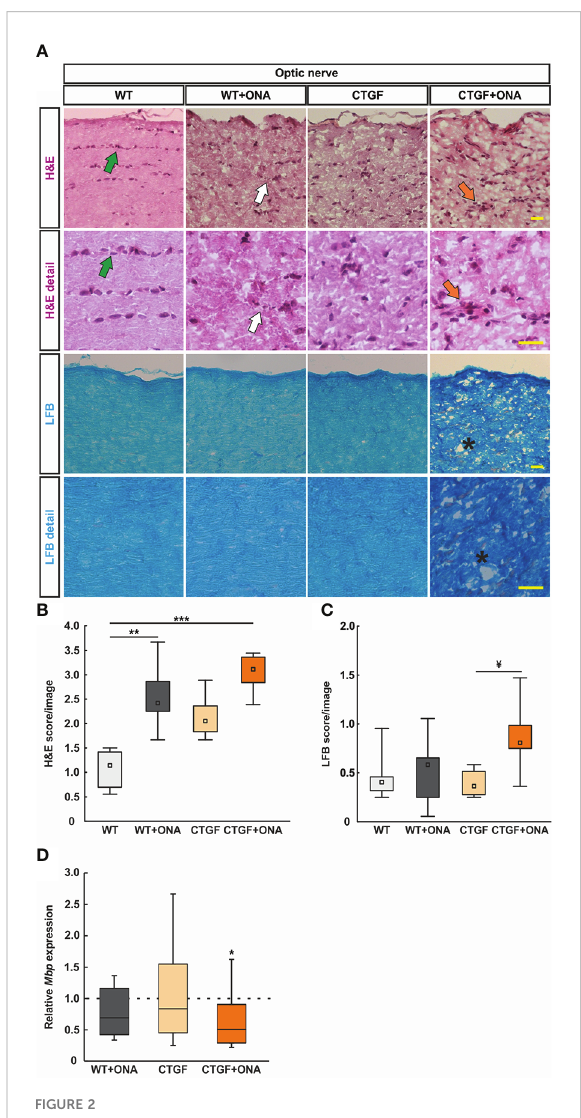
FIGURE 2 Enhanced optic nerve degeneration. (A) Longitudinal optic nerve sections were stained with H&E (cellular in fl ammation) and LFB (demyelination) and are shown as overview and in detail. In the H&E staining, healthy optic nerves show a linear formation of the nuclei (green arrows), which is disrupted in glaucomatous optic nerves (white arrows) and might comprise cellular conglomerates (orange arrows). LFB stained myelin sheats in healthy optic nerves resembles combed bundles in a parallel arrangement, which is interrupted in CTGF+ONA optic nerves (stars). (B) The H&E score revealed a higher degree of cellular in fl ammation in WT+ONA and CTGF+ONA animals compared to WT. (C) The LFB score showed a disruption of myelin in CTGF+ONA optic nerves compared to CTGF animals. (D) The mRNA expression levels of Mbp were signi fi cantly downregulated in CTGF+ONA optic nerves compared to controls. Values are median +/- interquartile range +/- range for histology and median ± quartile ± minimum/maximum for RT-qPCR. The dotted line in (D) represents the relative expression of the WT group. *p<0.05, **p<0.01 and ***p<0.001 vs . WT; and ¥ p<0.05 vs . CTGF. Scale bars: 20